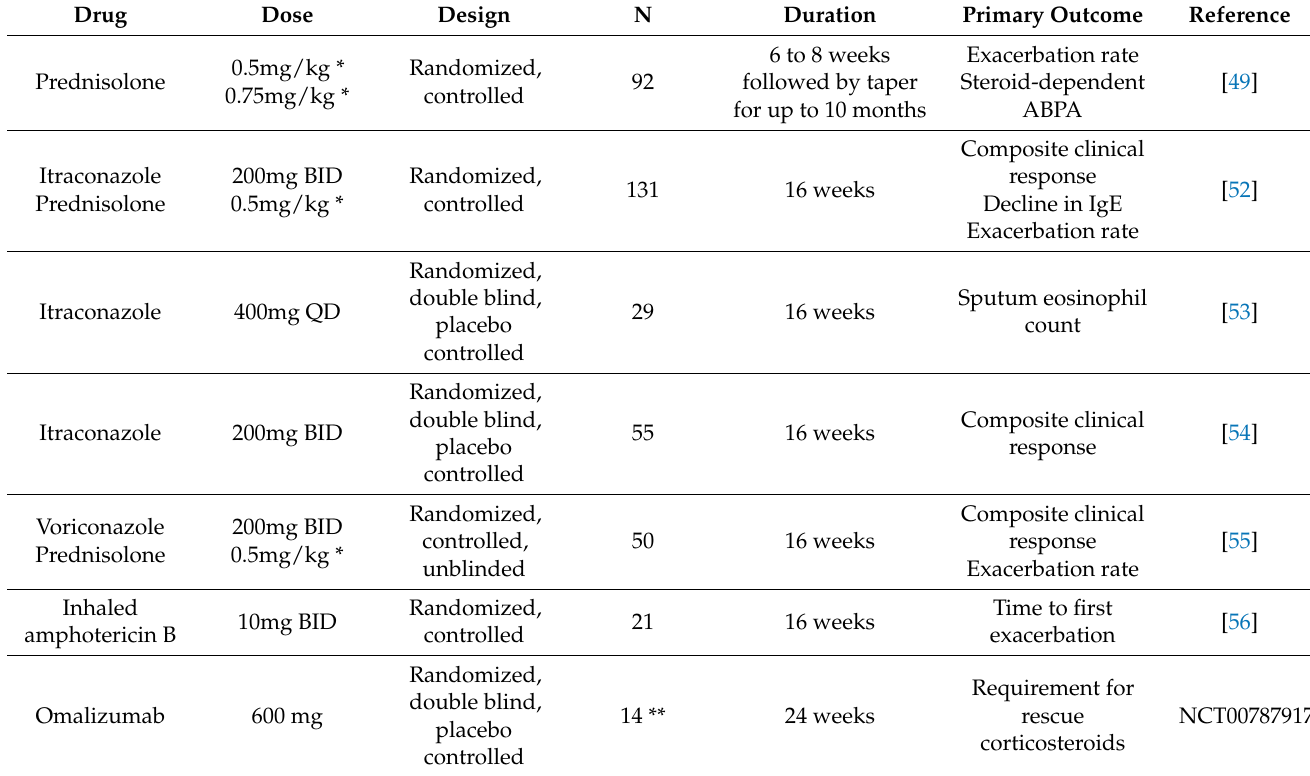
Table 1. Randomized, controlled clinical trials conducted in